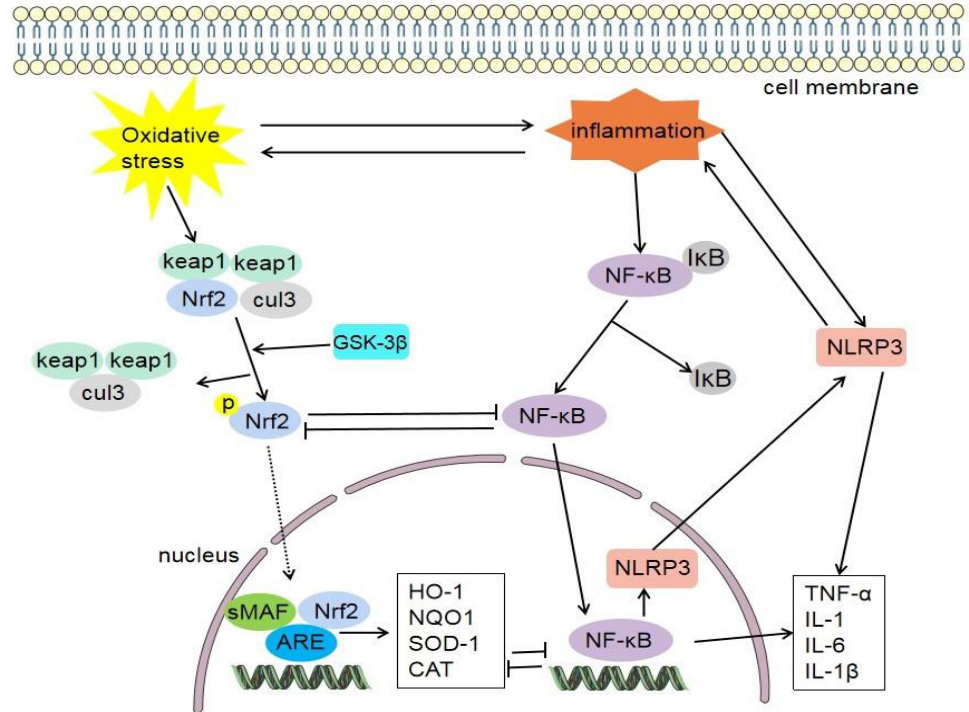
Figure 5. NF- κB is usually associated with IκB and forms stable NF - κB/IκB complex. Inflammatory reaction promotes the dissociation of NF- κ B/I κ B complex and separates active NF- κ B. NF- κ B can promote the expression of NLRP3, and then promote the inflammatory response. NF- κ B can also promote the release of inflammatory factors (TNF- α , IL-1, IL-6, and IL-1 β ). Nrf2 can negatively regulate the NF- κ B signaling pathway. Keap1, cytoplasmic kelch-like epichlorohydrin-associated protein 1; Nrf2, nuclear factor erythroid 2-related factor 2; sMAF, small musculoaponeurotic fibrosar- coma; ARE, antioxidant response element; cul3, cullin-3; NLRP3, nod-like receptor family pyrin domain-containing 3; HO-1, heme oxygenase-1; NQO1, quinine oxidoreductase 1; SOD-1, superoxide dismutase-1; CAT, catalase; NF- κ B, Nuclear factor-kappa B; I κ B, inhibitor κ B; IL-1 β , interleukin-1 β ; TNFα, tumour necrosis factor -alpha.